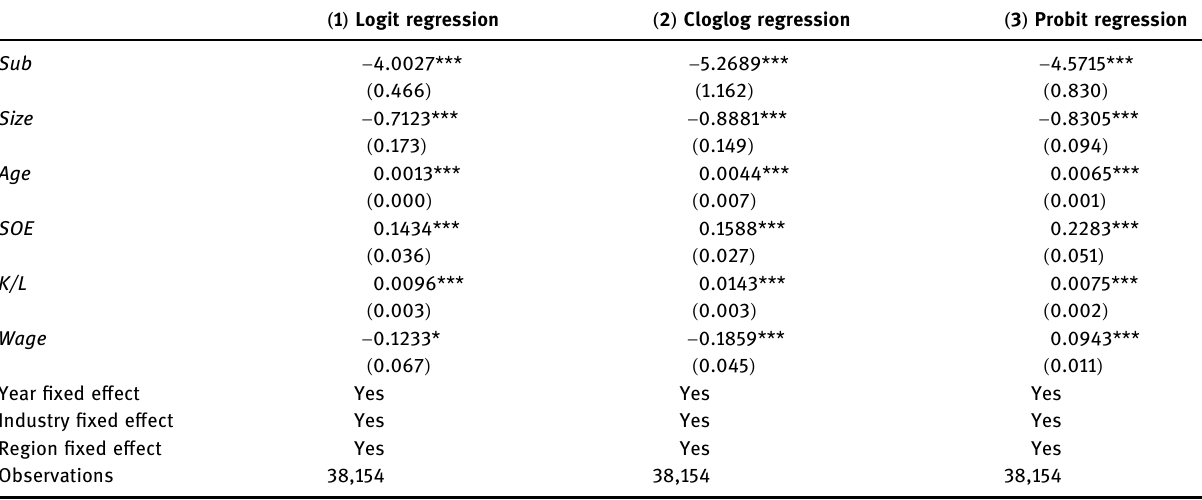
Table 7: Regression results based on matched